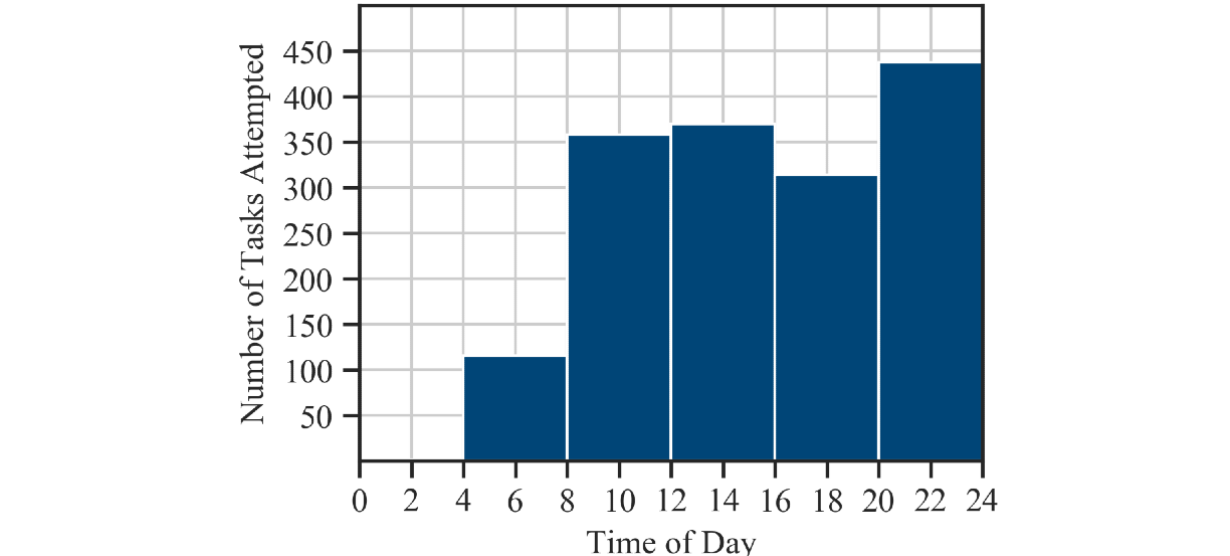
Figure 5. Distribution of PVT and ADD tasks attempted by time of day (binned into 2-hour intervals). Only one task was attempted in the 12AM-4AM